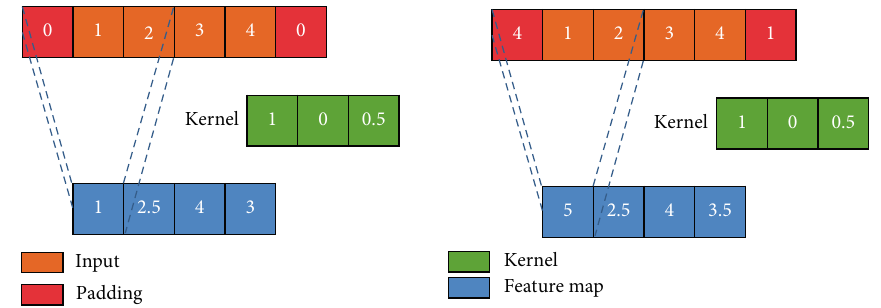
Figure 5: (a) Zero padding and its receptive fi eld. (b) Circular padding and their convolutional results.